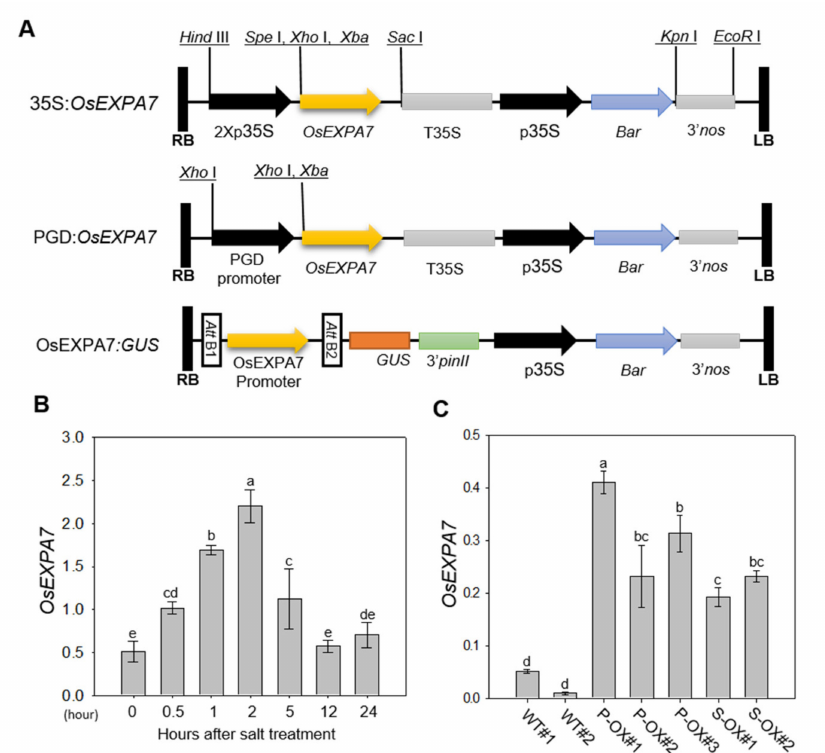
Figure 1. Vector construction and expression analysis of OsEXPA7 in response to salt stress in wild type and transgenic rice plants. ( A ) Vector construction of transgenic rice lines: 35S: OsEXPA7 , PGD: OsEXPA7, and OsEXPA7 : GUS. RB, right border. LB, left border. 35S, cauliflower mosaic virus 35S promoter. TNOS, nopaline synthase terminator. Bar , selection marker. ( B ) Expression pattern of OsEXPA7 at di ff erent time points (0, 0.5, 1, 2, 5, 12, and 24 h), after 150 mM NaCl treatment, determined by